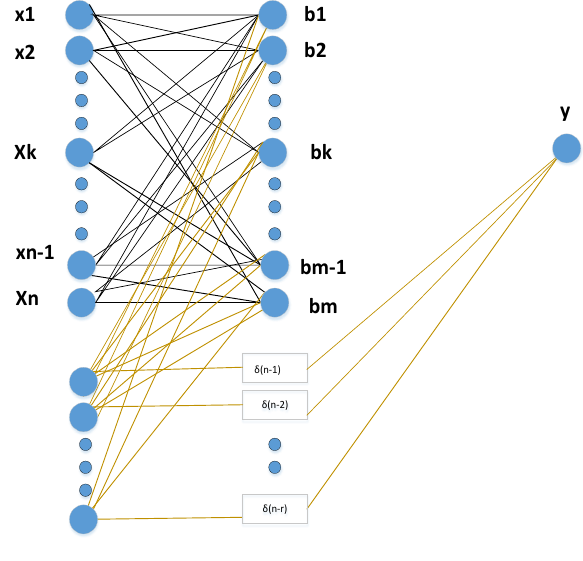
Figure 2. Functioning of